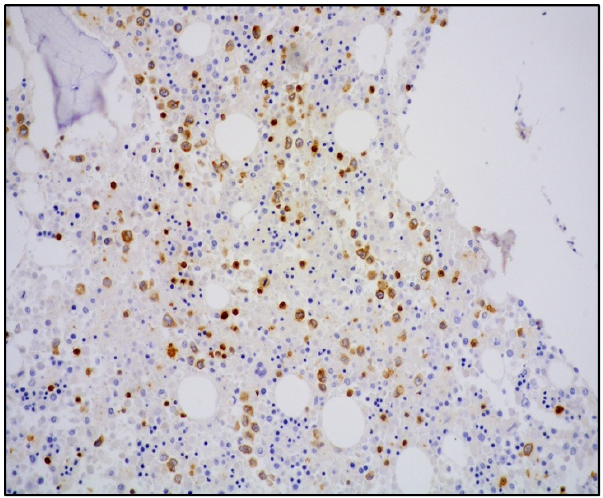
Figure 3. Medium-power view showing bone marrow with CD3-positive atypical cells within sinusoidal spaces (CD3 immunostaining, 100× magnification, previously unpublished, original image from S.A.).